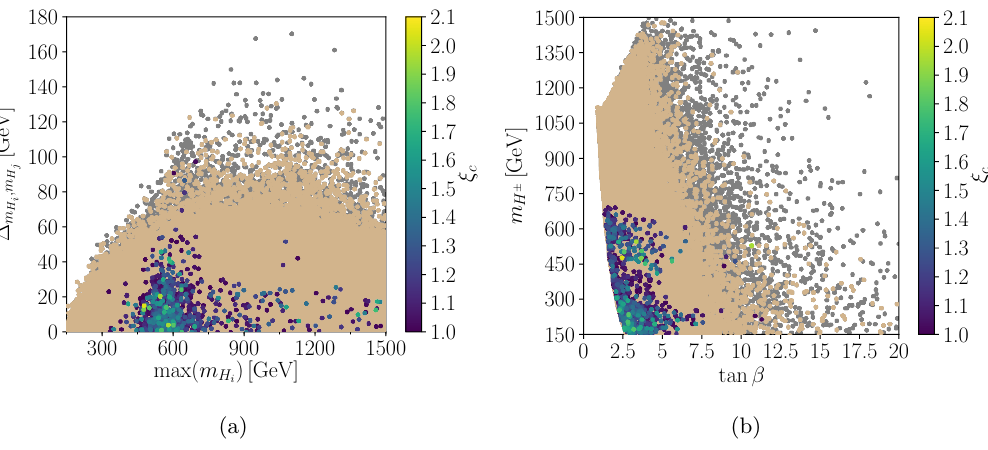
Figure 4 . N2HDM T1: Left: the minimum mass gap (cid:1) m masses. Right: charged Higgs boson mass m (cid:12)gure 3. The di-Higgs search constraints are